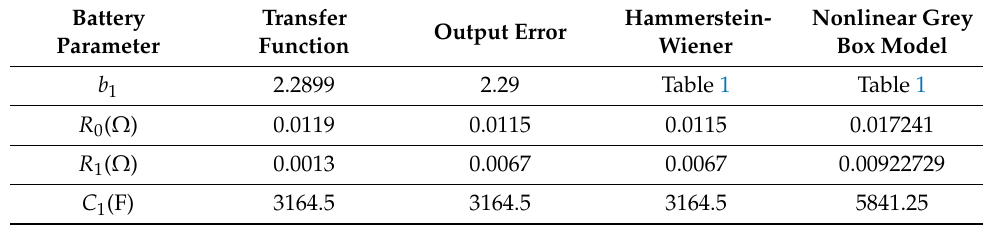
Table 6. Estimated battery parameters in each model